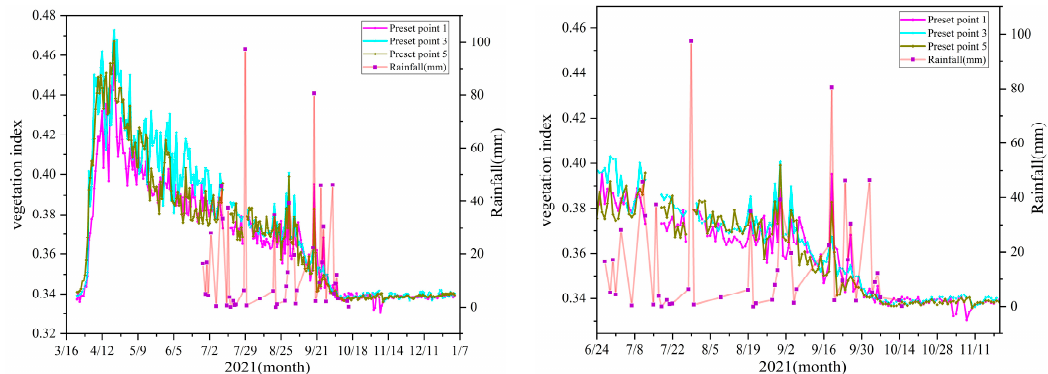
Figure 10. Growth changes at different preset points during the rainy